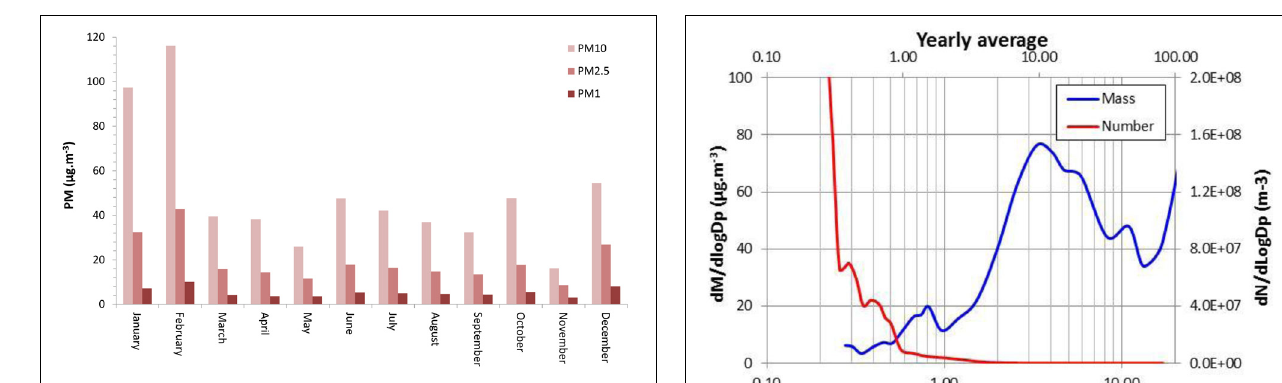
FIGURE 9 | Monthly averaged PM 1 , PM 2 . 5 , and PM 10 concentrations, for each month of 2011. Values for December are less representative of average conditions during this month because of important measuring interruptions.